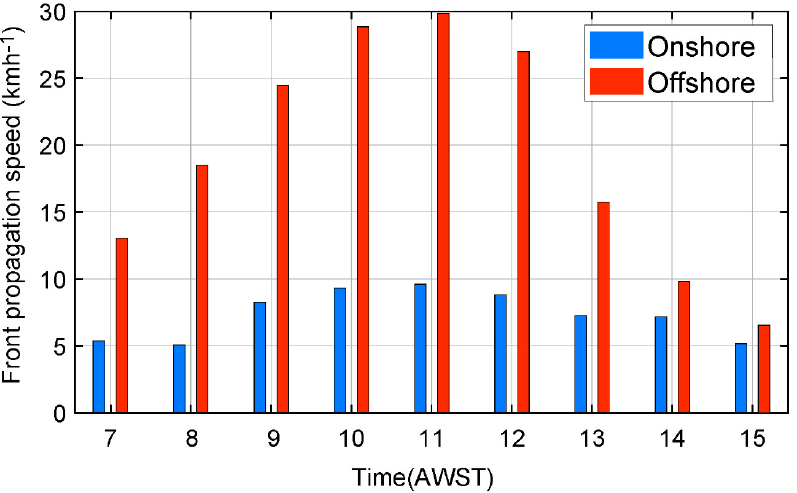
Figure 12. Time variability in mean propagation speeds of the sea breeze fronts onshore (blue) and offshore (red). Means were obtained over a 10-day cycle (1–10 December 2016).